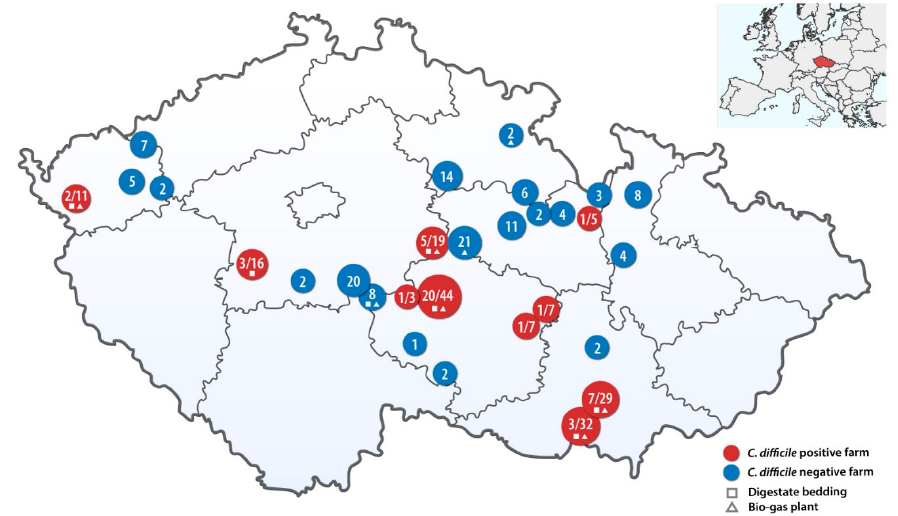
Figure 1. Geographic distribution of farms in the study. Red circles represent farms with the occurrence of C. difficile (number of positive/number of samples tested). Blue circles represent farms without the occurrence of C. difficile with number of samples tested.